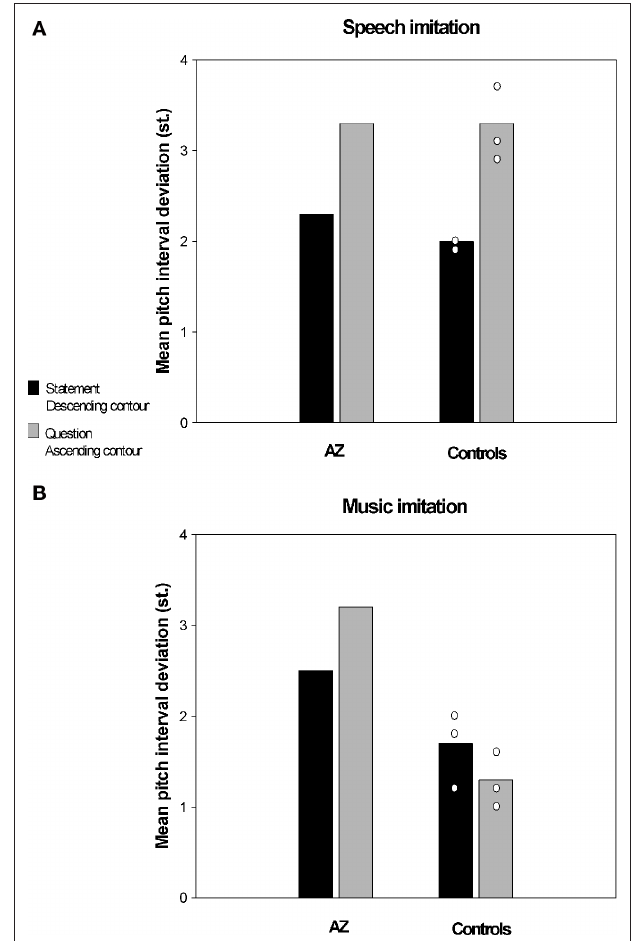
FiguRe 2 | imitation of pitch intervals by a poor-pitch singer (AZ) and three matched control participants, (A) in spoken utterances and (B) in a musical context (i.e., singing). Accuracy in terms of relative pitch (pitch interval deviation)